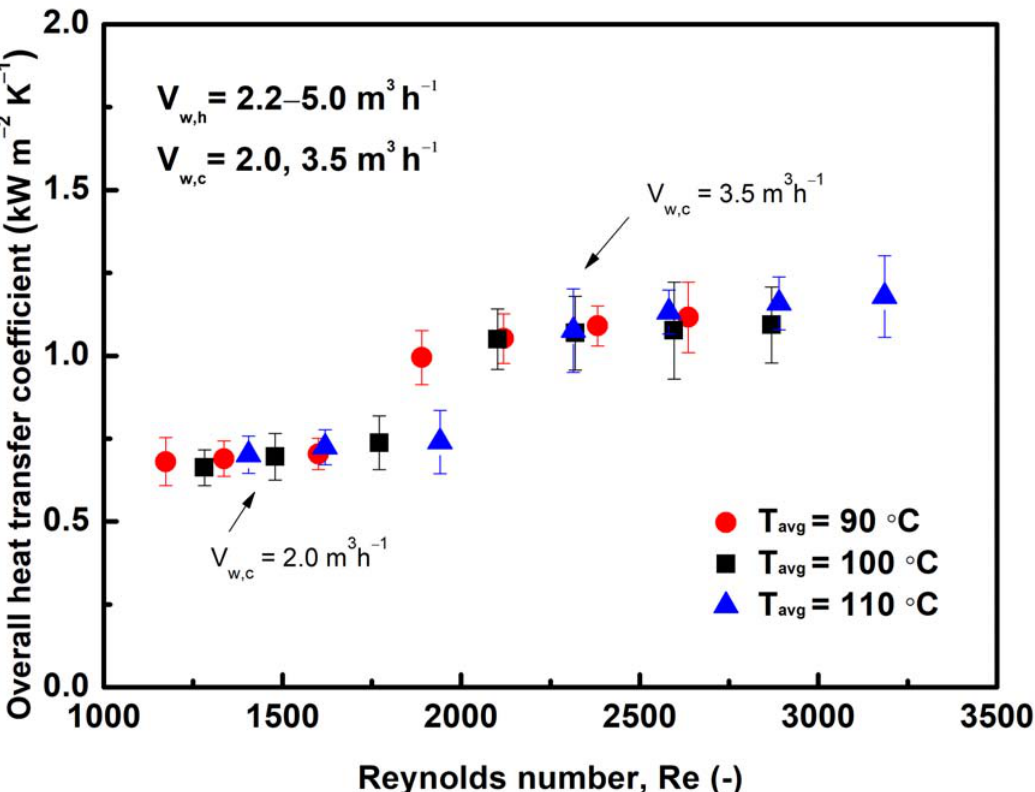
Figure 5. Variation in the overall heat transfer coefficient with respect to the Re and average temperature in PSHE. The convective heat transfer coefficients of water on the plate and shell sides of the PSHE were estimated using the modified Wilson plot method [15,16]. The convective heat transfer coefficient of water in the PSHE can be expressed by Equation (15). In this study, the exponents of Pr and viscosity term were fixed at 1/3 and 0.17, respectively, according to Lee et al. [16] and Heavner et al. [17].